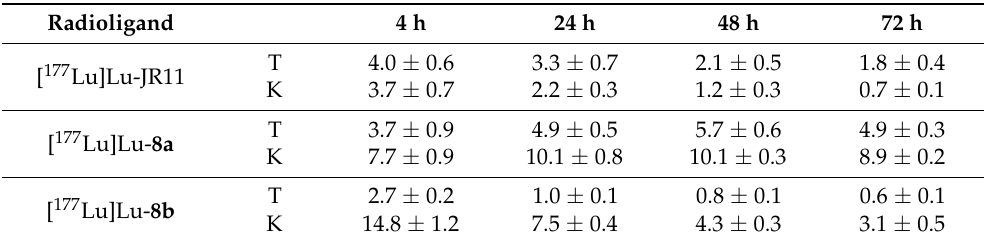
Figure 2. Representative MIP images of SPECT/CT scans of ( A ) [ 177 Lu]Lu- 8a , ( B ) [ 177 Lu]Lu- 8b, and ( C ) [ 177 Lu]Lu-JR11 at 4, 24, 48, and 72 h from H69 human xenograft-bearing mice (right shoulder; white arrows indicate tumors; n = 4). Color scale represents % ID/mL. Table 3. SPECT quantification of xenograft tumor (T) and kidneys (K) per group at 4, 24, 48, and 72 h post-injection, represented in % ID/mL.